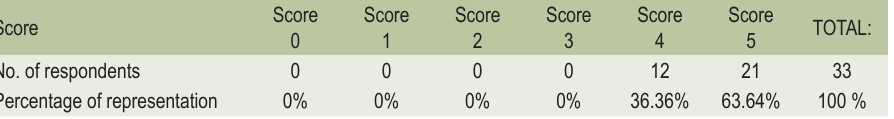
TABLE 8. . Condition of respondents after treatment - Chronic lumbar pain syndrome